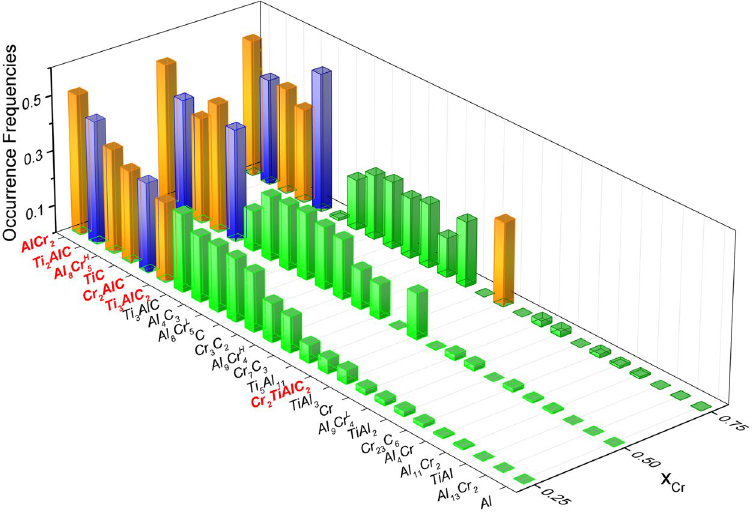
Figure 4. Stochastic phase stabilities of Cr 25 , Cr 50 , and Cr 75 at 1300 °C. Note that other possible stable phases exist, as the result of high degree of uncertainty introduced via all model parameters of all the considered